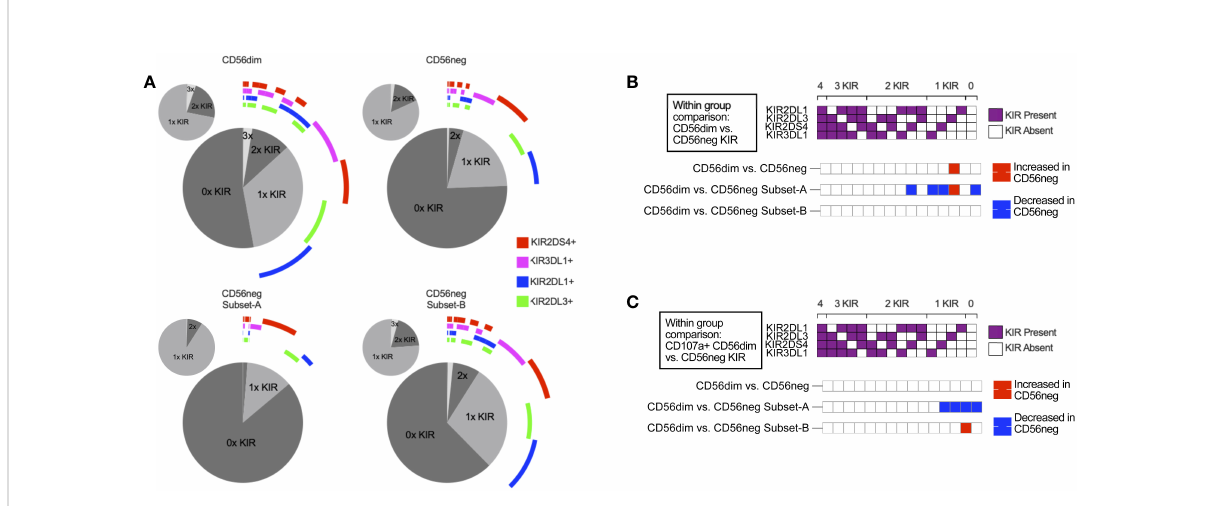
FIGURE 5 KIR repertoire comparison of CD56neg NK subsets. (A) these charts show the combinations of KIRs being expressed by CD56dim cells, CD56neg cells, and CD56neg Subset-A and -B from the SDY517 Immport.org dataset. The central pie chart with the encircling bars shows the proportion of either the CD56dim or CD56neg cell subsets that express no KIR, a single KIR, or combinations of KIRs. The bars around the plot denote the presence of a speci fi c KIR corresponding to the legend color, and the smaller pie charts orbiting the central plot show the proportion of subset KIRs when KIR-negative cells were excluded. (B) this heatmap shows a comparison of KIR repertoire frequency between CD56dim and the CD56neg, Subset-A and -B cells (SDY517). (C) this heatmap shows cells that express CD107a + following K562 stimulation, comparing the KIR repertoire of CD107a + CD56dim to CD56neg cells, and CD56neg Subset-A and -B (SDY517). Signi fi cantly varying KIR repertoire frequency between subsets (p < 0.05) are shown as red based on two-way ANOVA results with multiple comparisons corrected using the S ı ́ da ́ k